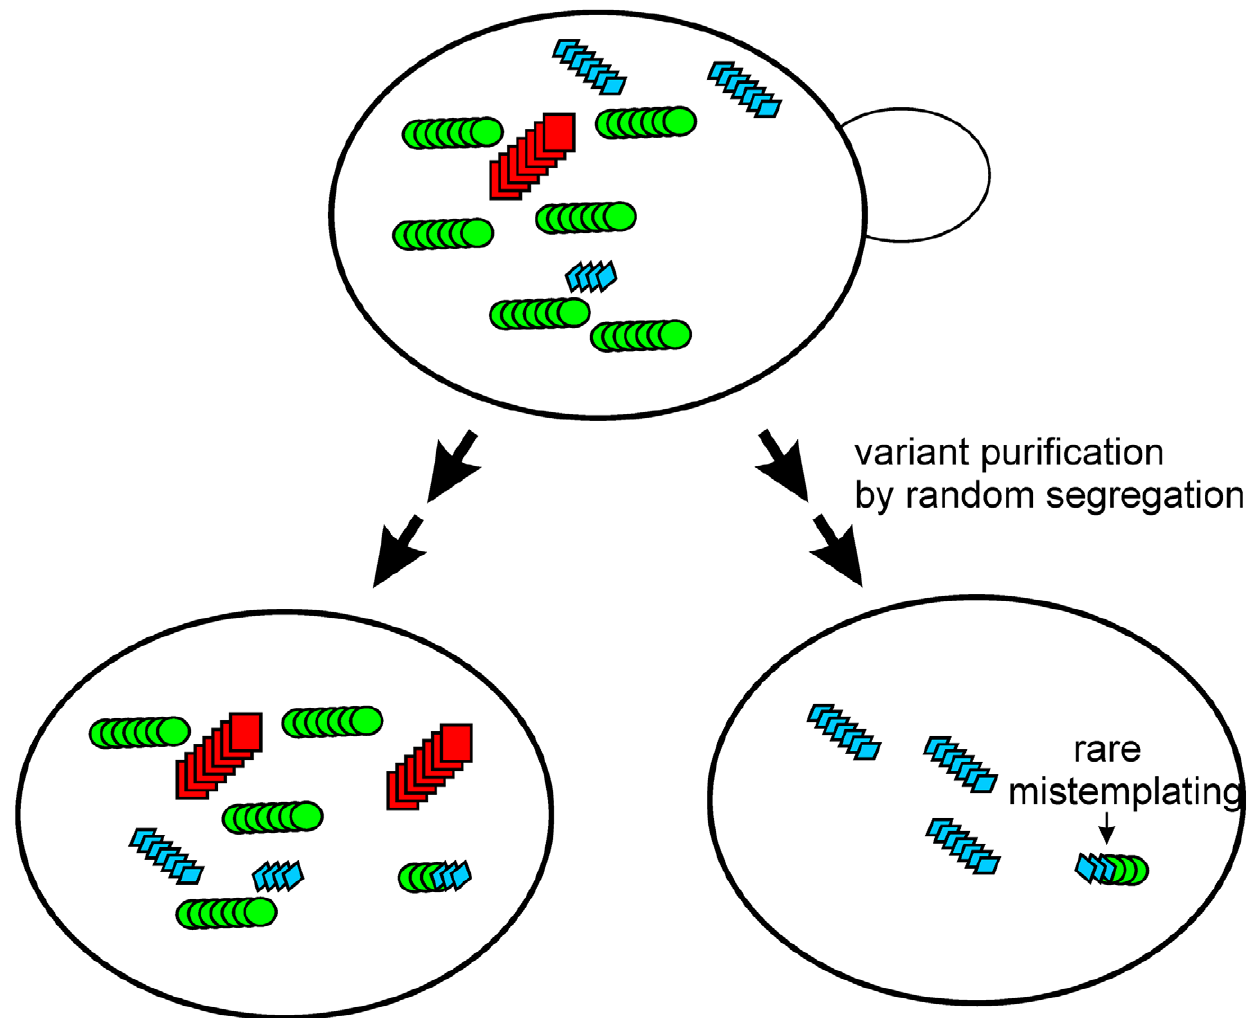
Figure 2. The prion cloud model [ 56,57 ] applied to yeast. Segregation of different prion variants on mitotic growth is followed by re- emergence of different variants, presumably due to mis-templating.